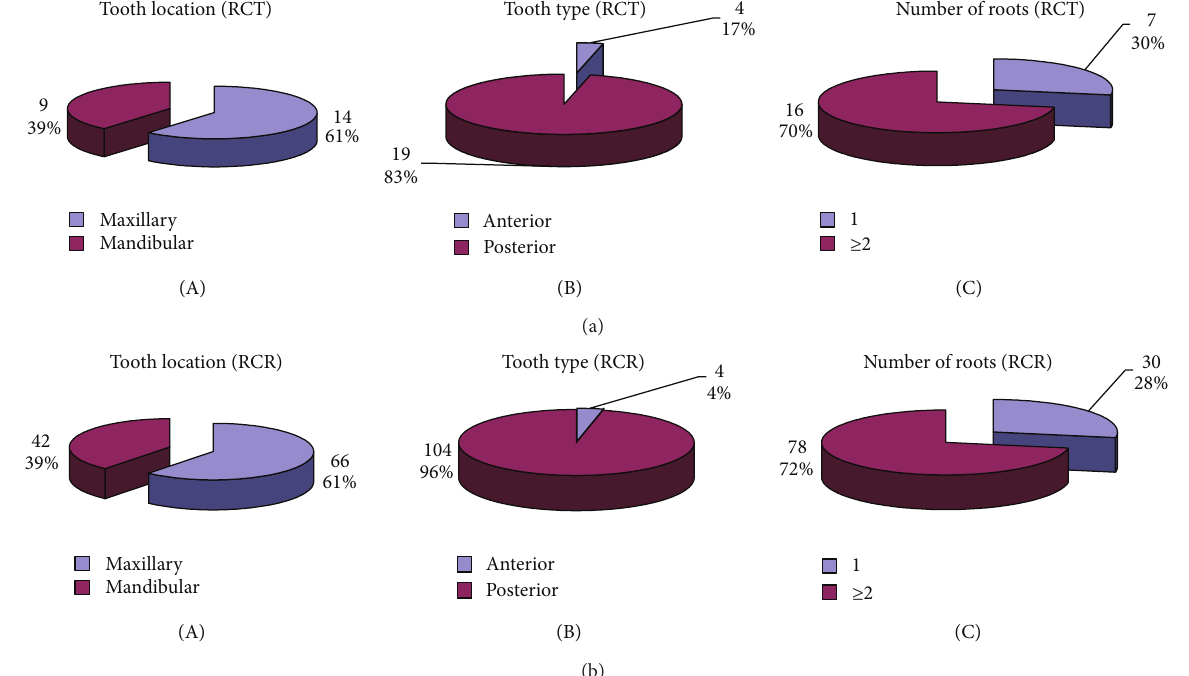
Figure 1: Tooth specifications. (a) For the root canal treatment (23 teeth): tooth location (A), tooth type (B), and number of roots (C). (b) For the root canal retreatment (108 teeth): tooth location (A), tooth type (B), and number of roots